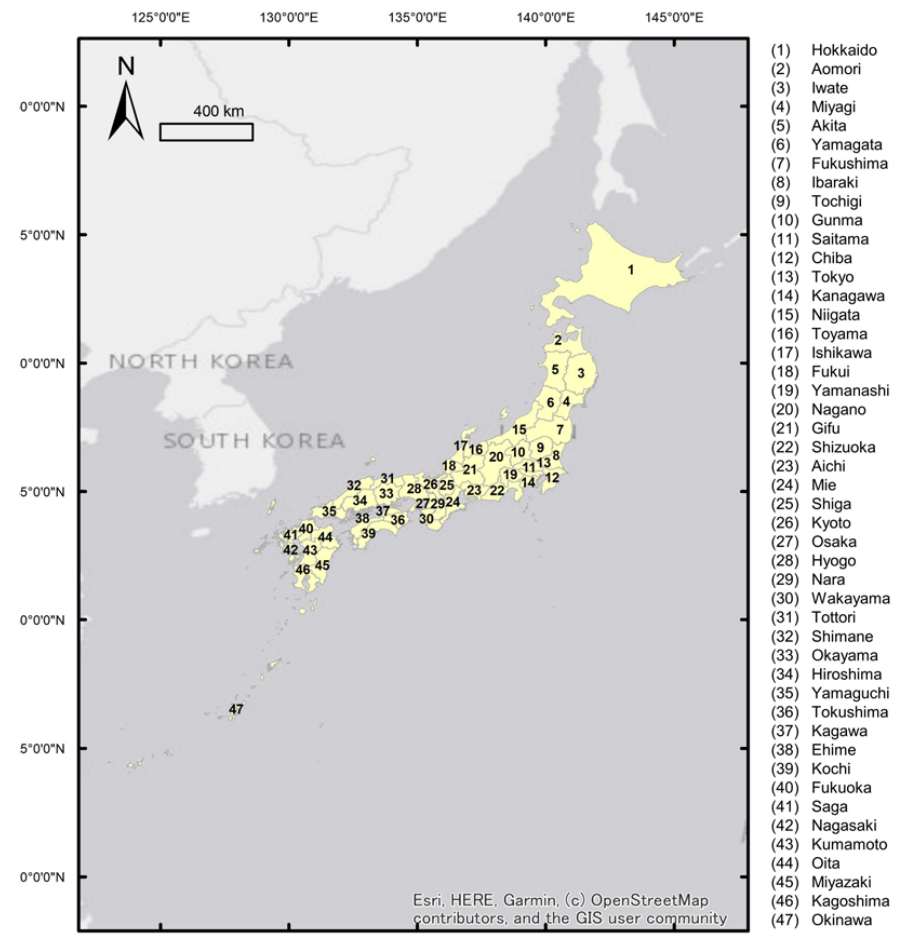
Figure A1. The 47 prefectures of Japan.